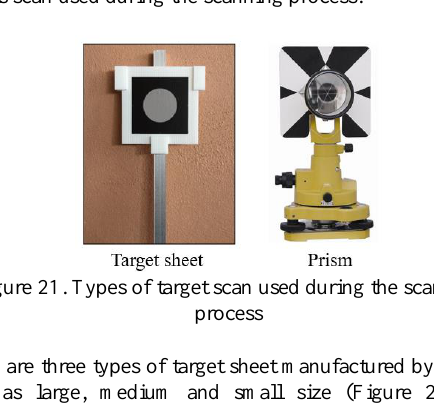
Figure 23. The example of data configuration for scanner station are stored in SD